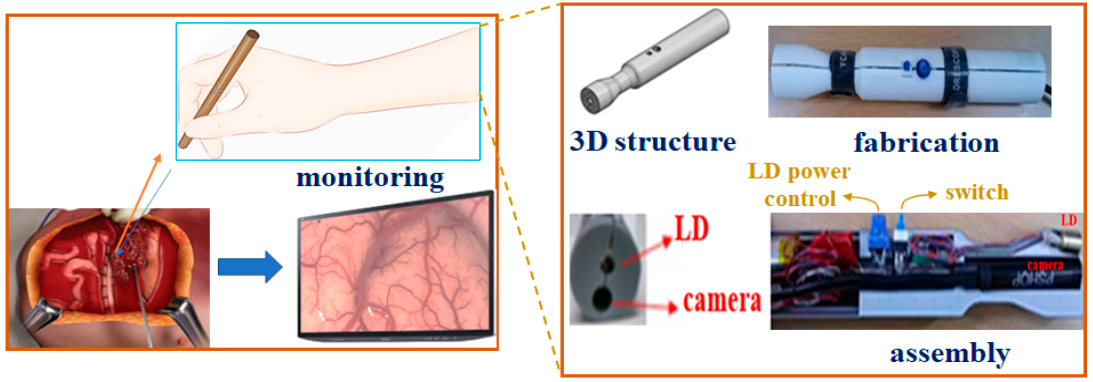
Figure 4. Fabricate a pen-type probe using 3D printing technique.